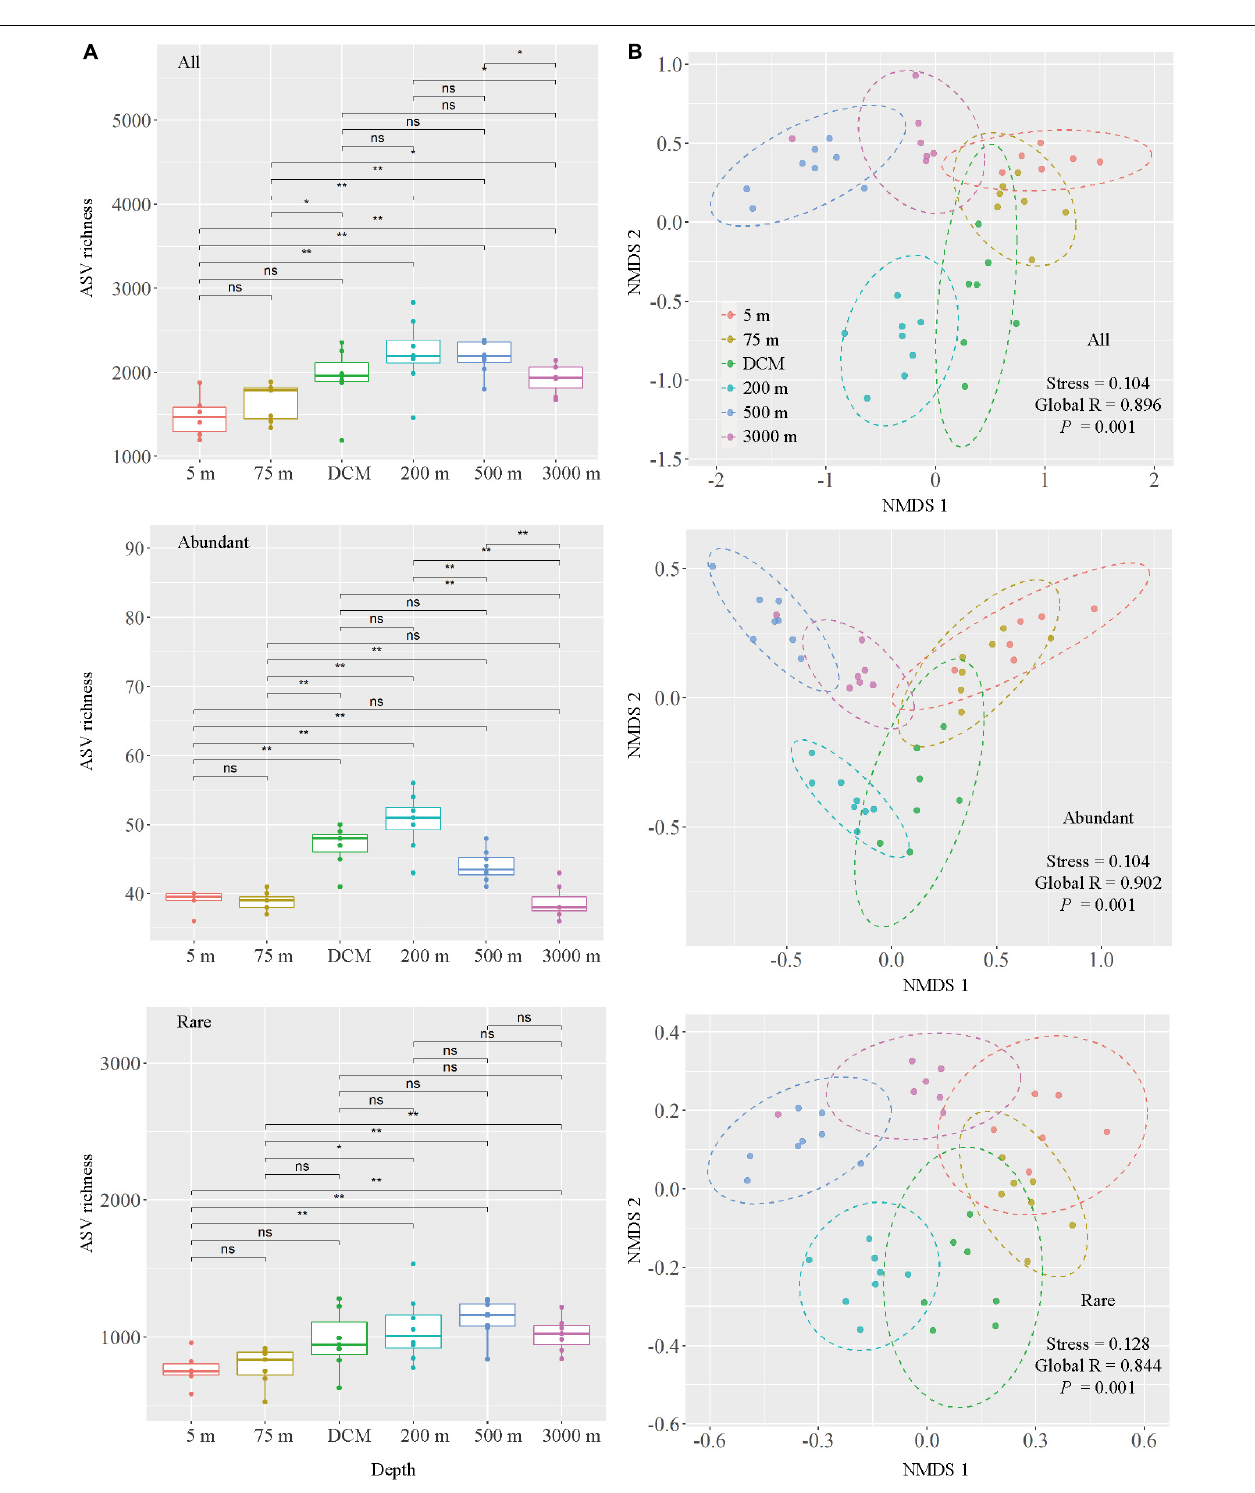
FIGURE 3 | Comparison of microbial communities among six depth groups (5 m, 75 m, DCM, 200 m, 500 m and 3,000 m), DCM, denoted as deep chlorophyll a maximum layer. (A) Boxplots of ASV richness in six depth groups. Wilcox tests were calculated on the alpha diversity indices between depths. * Represents a statistically significant difference of P < 0.05; ** represents a statistically significant difference of P < 0.01, ns represents no statistically significant difference. (B) Non-metric multidimensional scaling (NMDS) ordination based on Bray–Curtis similarity.